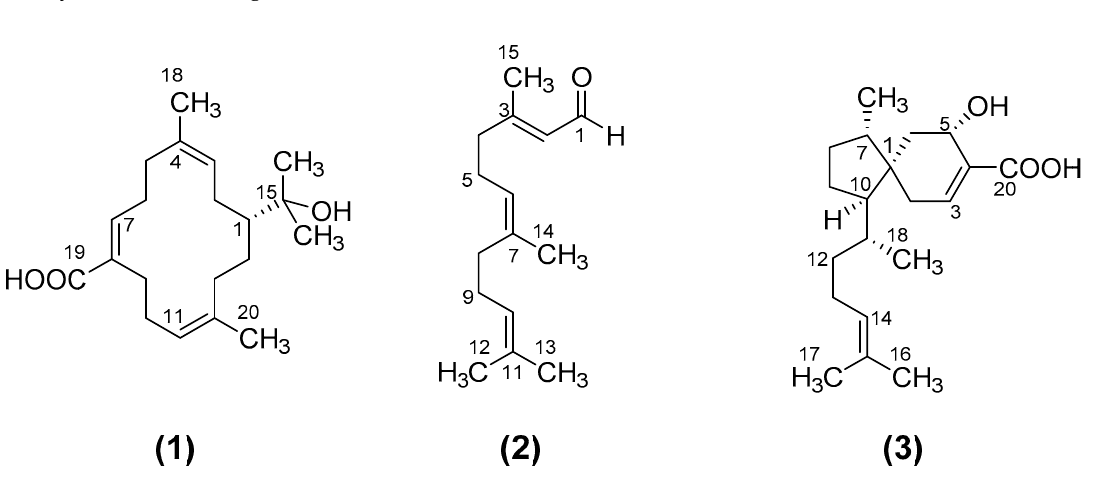
Figure 1. Compounds isolated in this study from Eremophila lucida.